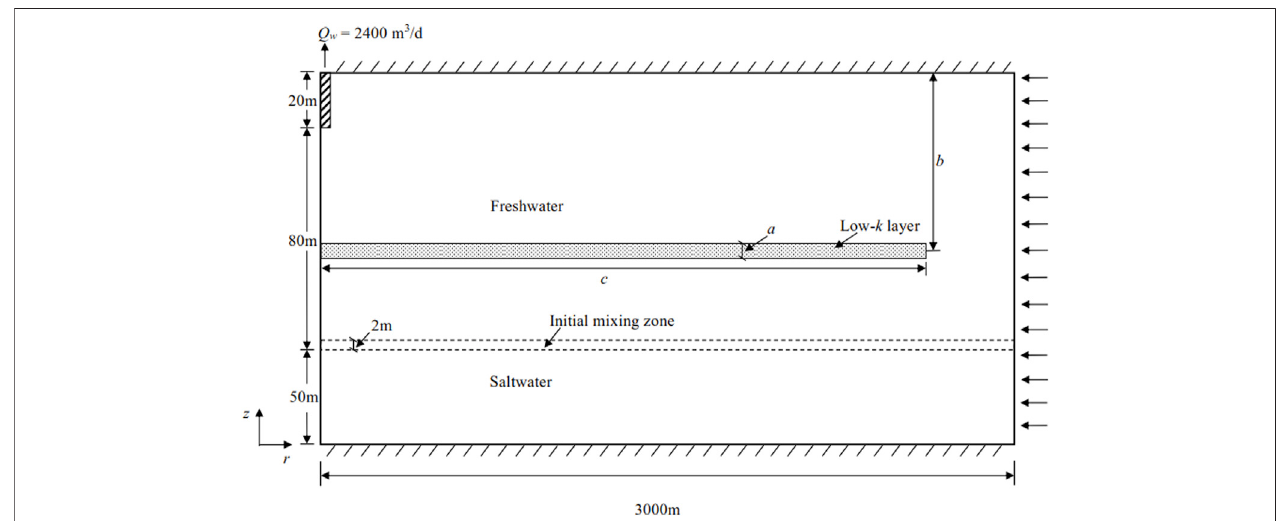
FIGURE 1 | Conceptual model of a saltwater up-coning problem (modi fi ed from Figure 1 in Zhou et al. (2005).